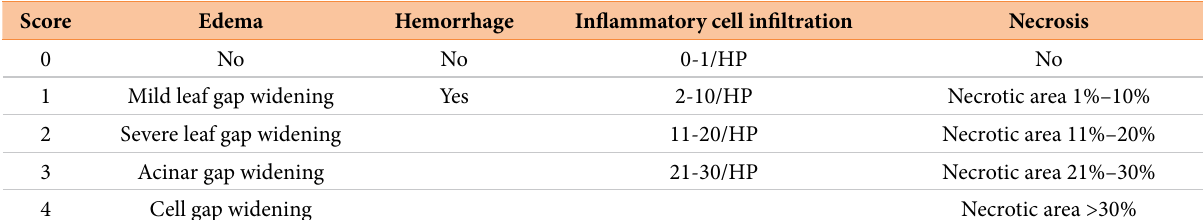
Table 1 - Pathological scoring criteria for pancreas.